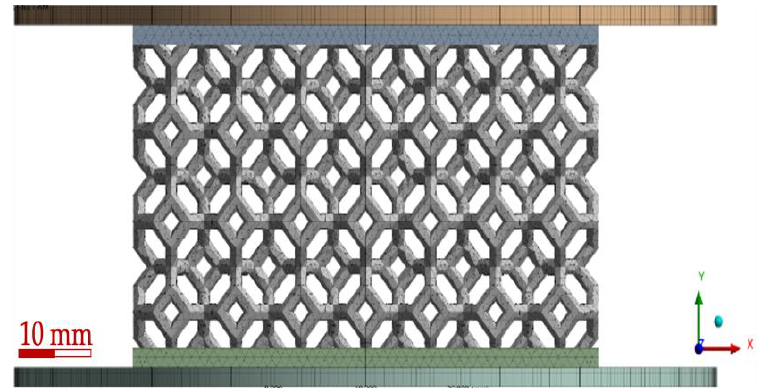
Figure 3. None-graded lattice full mesh with bottom plate and